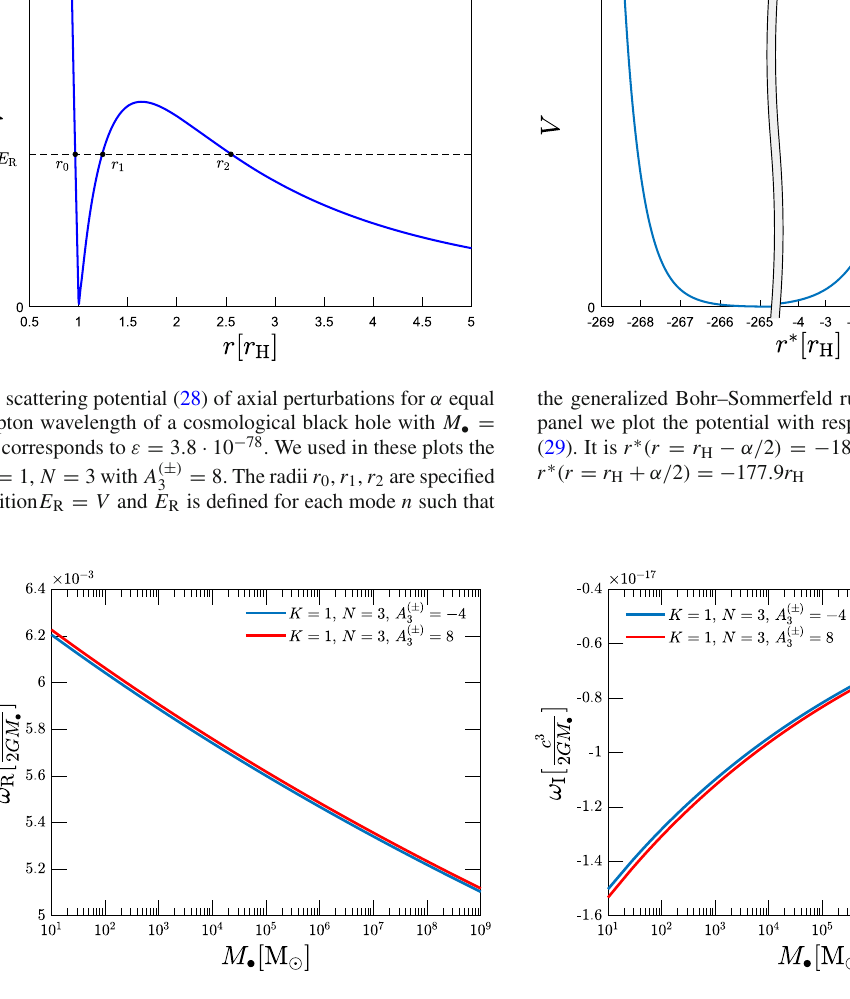
Fig. 4 The real (left panel) and imaginary (right panel) frequency of mal modes’ values of these two solutions bound all values of solutions { K = 1 , N = 3 } , { K = 2 , N = 5 } . There is also strong numerical the quasinormal mode n = 0, (cid:14) = 2 of the cosmological black hole withrespecttoitsmass M • ,indimensions c 3 / 2 GM • .Thetwolinescor- evidence that they bound all solutions (8). Differences in the precise ( ± ) = 8 (red) and A ( ± ) = − 4 value of ε are respond to the two limiting solutions A 3 3 (blue) of the case { K = 1 , N = 3 } , depicted in Fig. 1a. The quasinor-